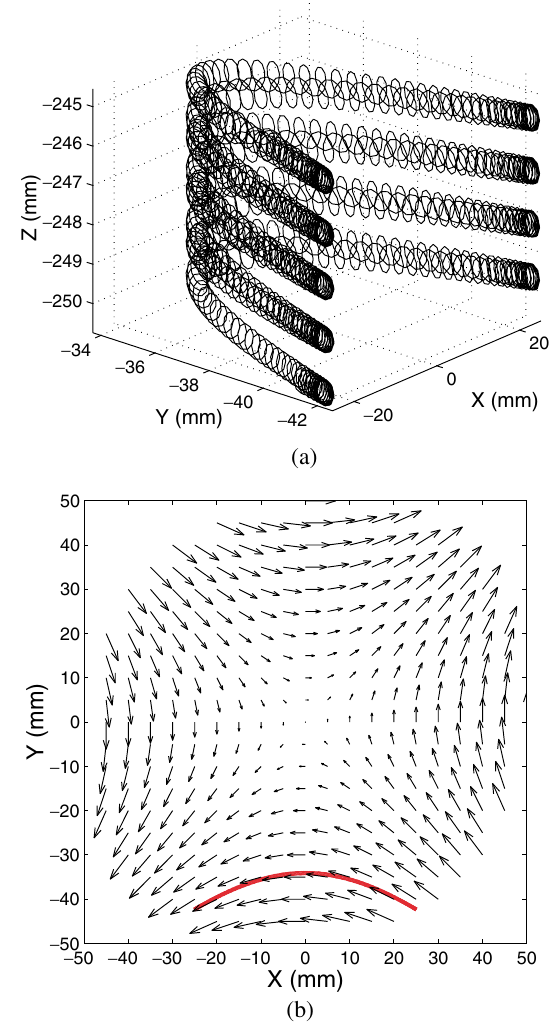
FIG. 13. (Color) Photoelectron trapping in a quadrupole mag- netic field during the train gap. (a) 3D orbit; (b) 2D orbit (red line); and quadrupole field (black